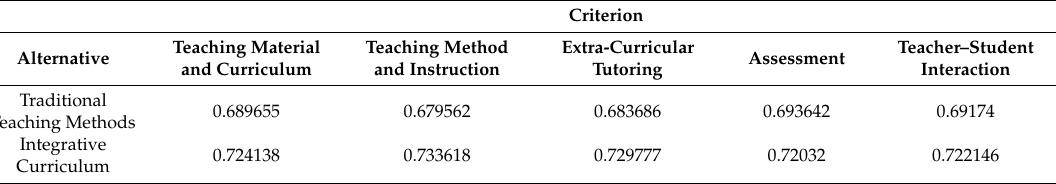
Table A1. The normalized decision matrix.